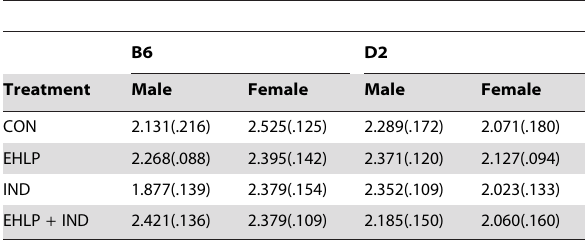
Table 4. Means and standard errors for activity in the closed